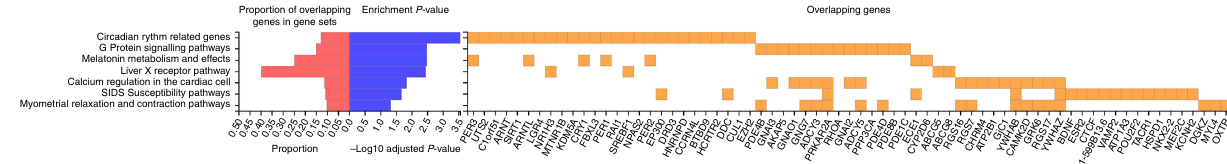
Fig. 3 WikiPathways gene sets overlapping Chronotype genes. Chronotype genes were identi fi ed using positional and eQTL mapping in FUMA ’ s GENE2FUNC process. Note that these results may differ to those produced by MAGMA